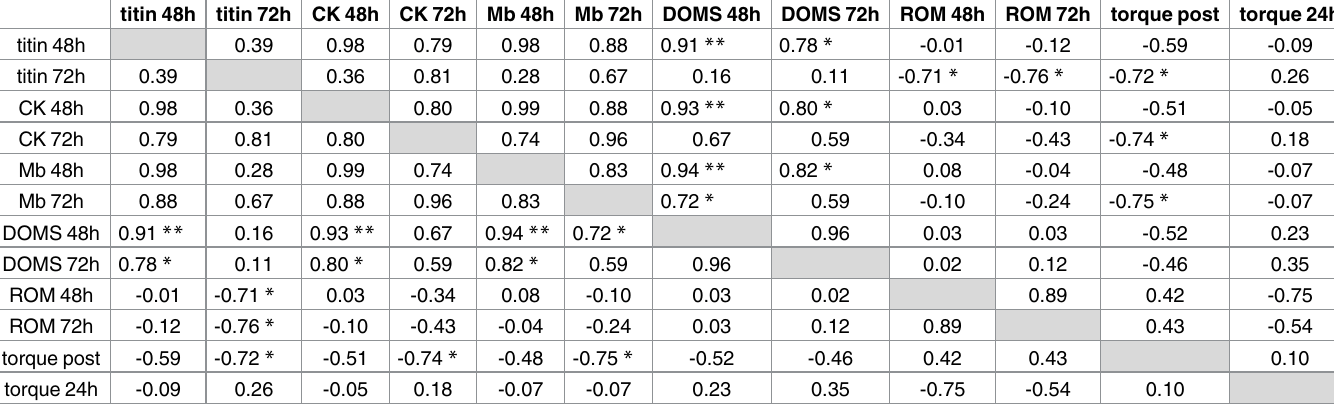
Table 3. Pearson’s correlation coefficient matrix of titin, muscle damage markers,and muscle